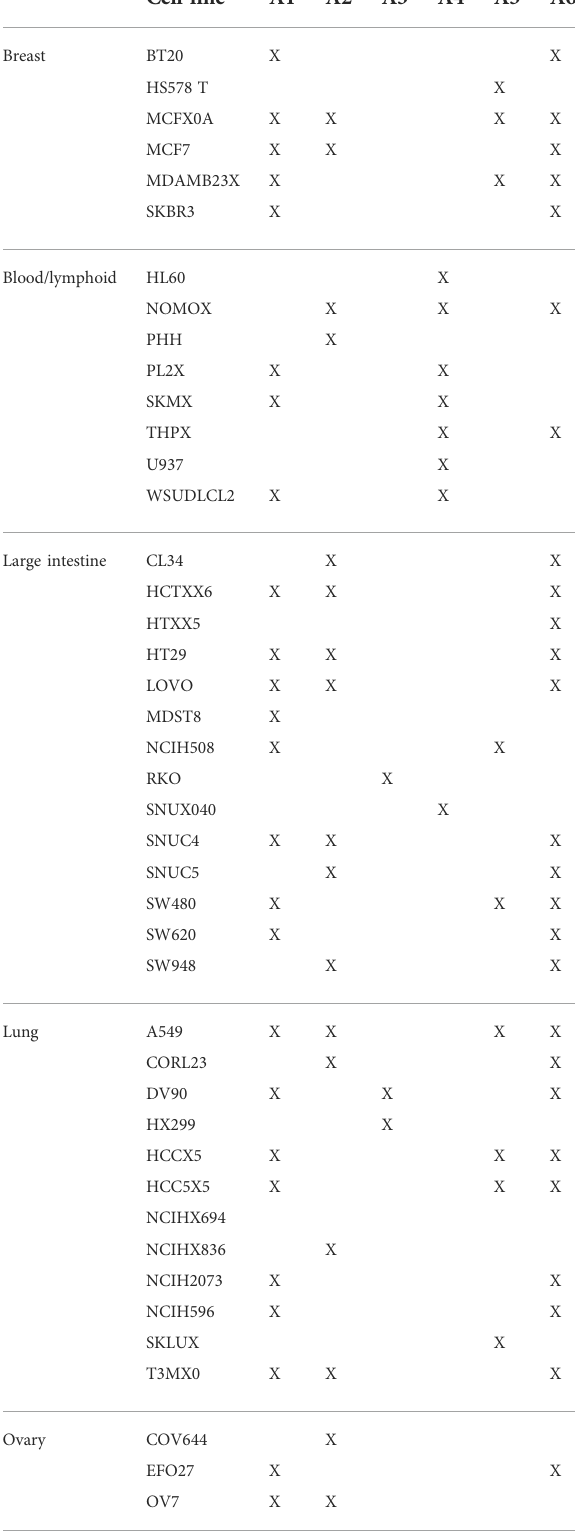
TABLE 1 Cancer cell line membership in different